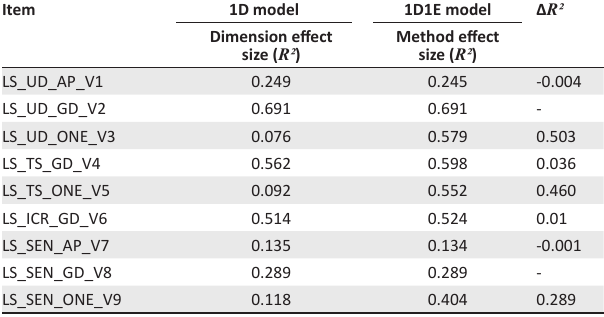
TABLE 6: Squared multiple correlations ( R² ) of